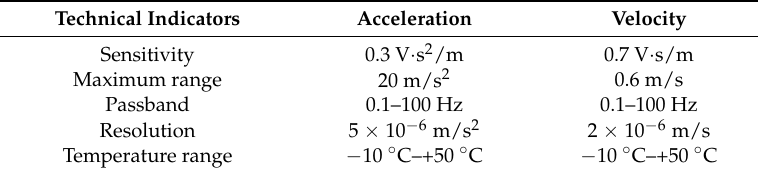
Table 4. The main performance indicators of the Accelerometer.